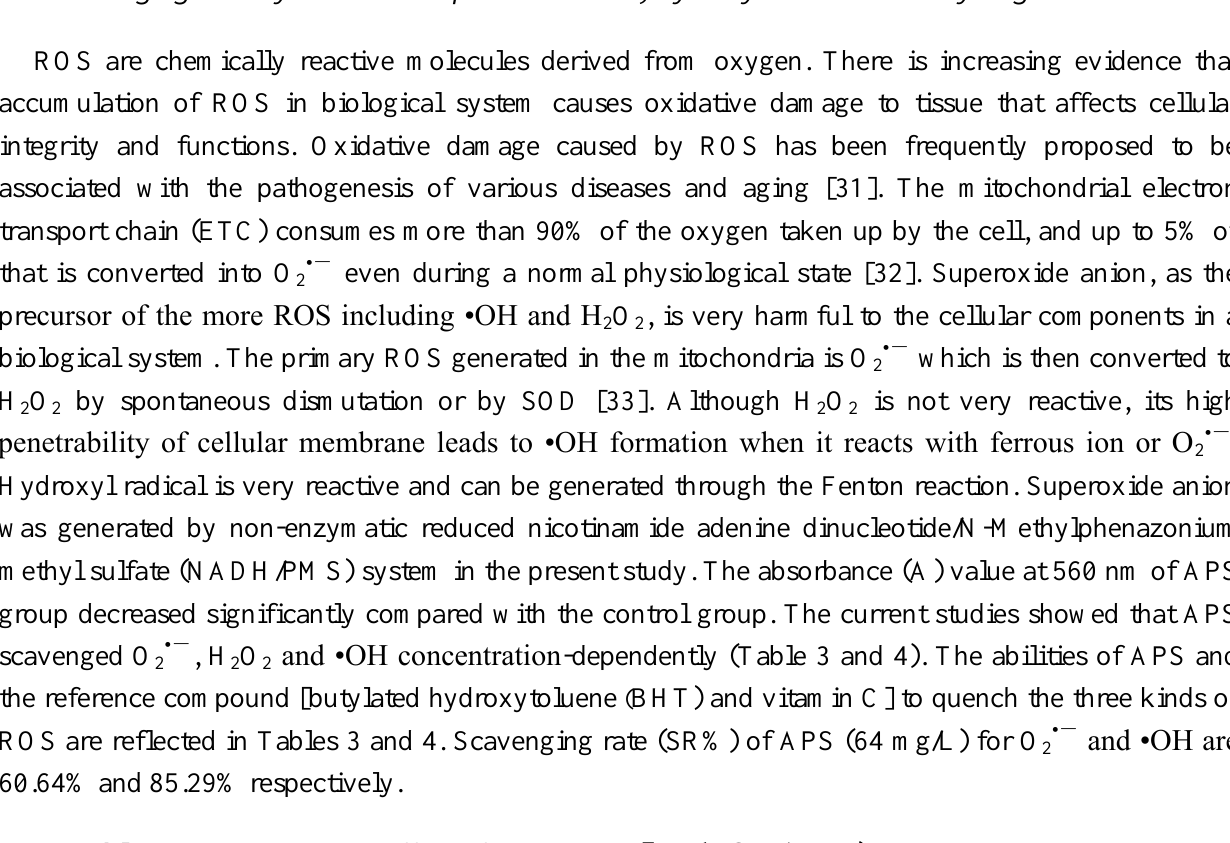
• － and •OH ( n = 6). Data were expressed as 2